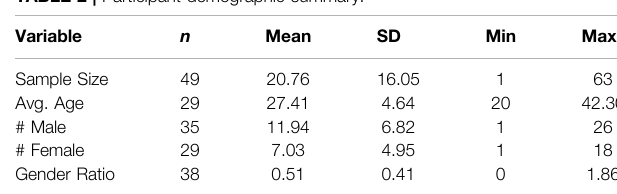
TABLE 2 | Participant demographic